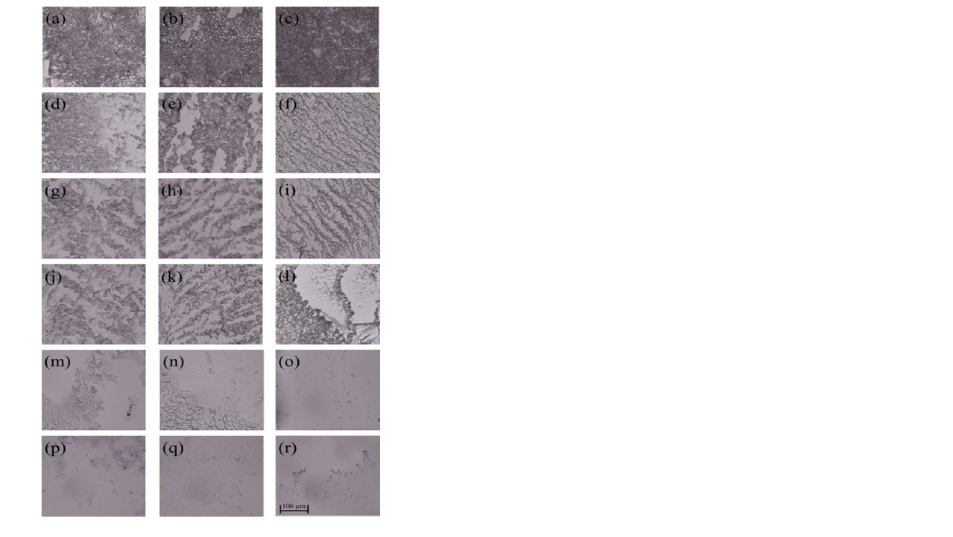
Figure 5. The inhibitory effect of AG-GT-1 on E. coli biofilms: ( a – c ) are the E. coli biofilms developed for 1, 3 and 5 days in control group, ( d – f ) are the E. coli biofilms treated with AG-GT-1 at a concentration of 1/4 MIC for 1, 3 and 5 days, ( g – i ) are the E. coli biofilms treated with AG-GT-1 at a concentration of 1/2 MIC for 1, 3 and 5 days, ( j – l ) are the E. coli biofilms treated with AG-GT-1 at a concentration of MIC for 1, 3 and 5 days, ( m – o ) show the E. coli biofilms treated with AG-GT-1 at a concentration of 2 MIC for 1, 3 and 5 days, ( p – r ) present the E. coli biofilms treated with AG-GT-1 at a concentration of 4 MIC for 1, 3 and 5 days, respectively.